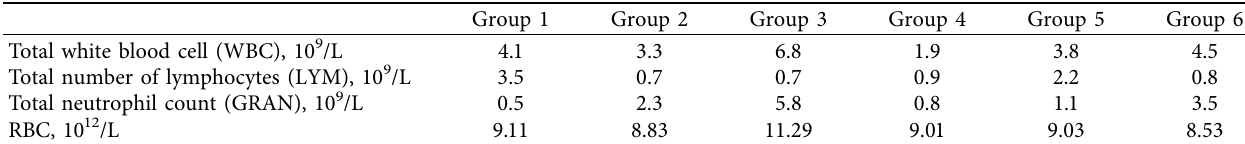
Figure 9: HE staining of major organs of mice in diferent treatment groups after treatment group. (a) Control group (200 μ g/saline solution, heart, liver, kidneys, × 200); (b) experimental group (200 μ g/CDDP, heart, liver, kidneys, × 200); (c) experimental group (200 μ g/ graphene carrier complex, heart, liver, kidney, × 200). Table 2: Blood routine examination results of nude mice in each